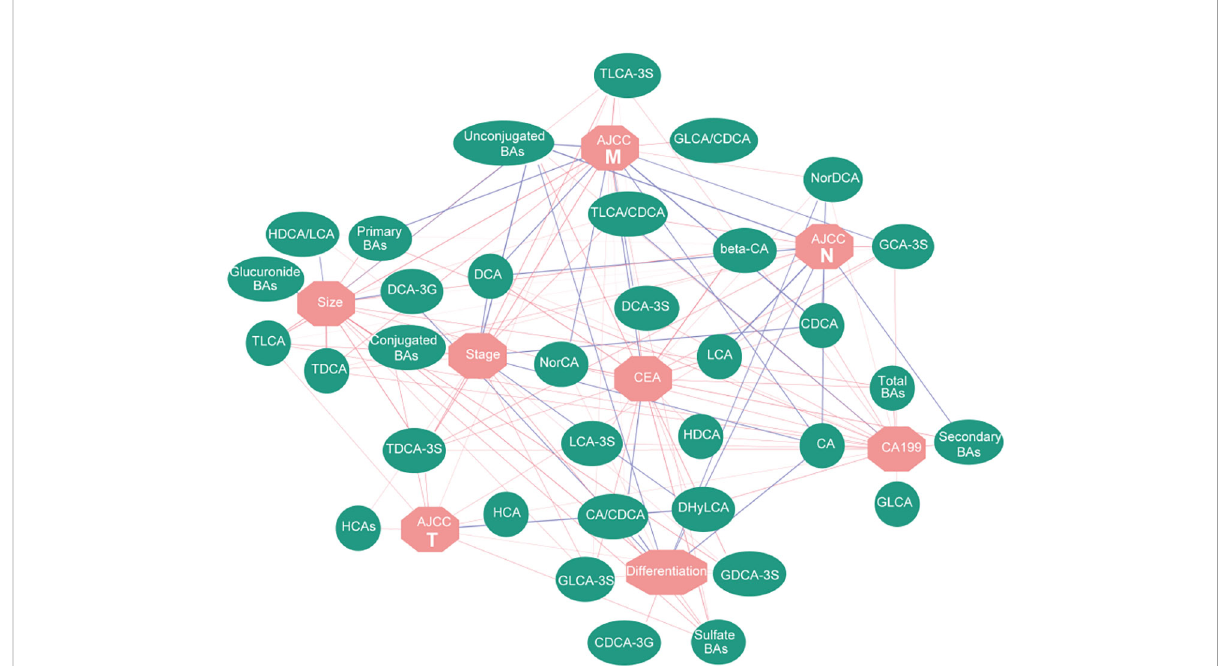
FIGURE 3 Correlation network based on Spearman correlation analysis. It shows the correlation between BAs and clinical traits. Red lines represent positive correlation, while blue lines represent negative correlation; the width of the line represents the correlation coef fi